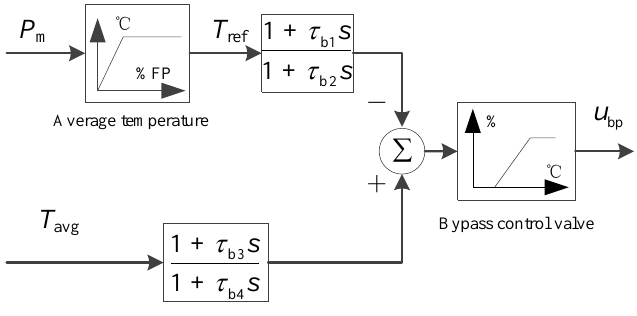
Figure 6. Steam turbine bypass control system diagram.